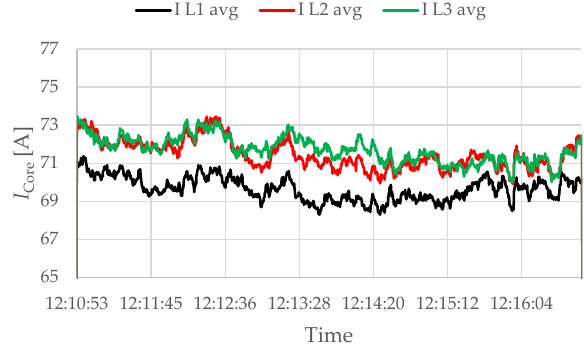
Figure 15. Cores currents measured in Substation 2. Sheaths cross-bonded according to: L1 → L2, L2 → L3, L3 → L1 (Sh3). Operation only with the analyzed line.